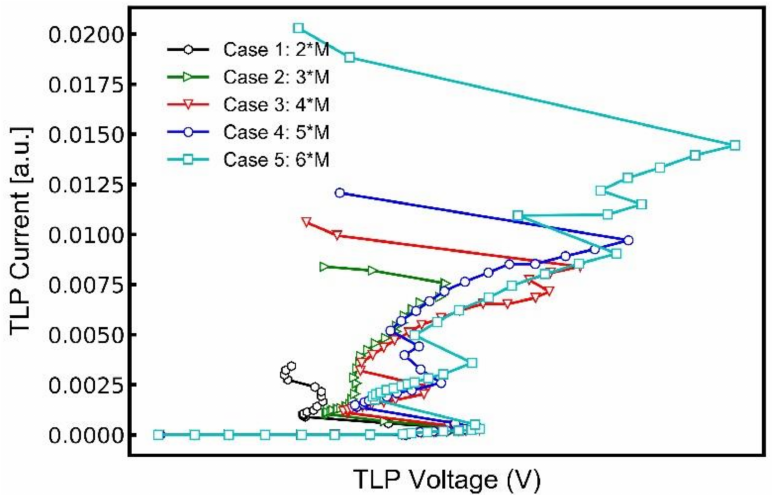
Figure 13. Measured multi-finger NMOS TLP IV curves with different NPL